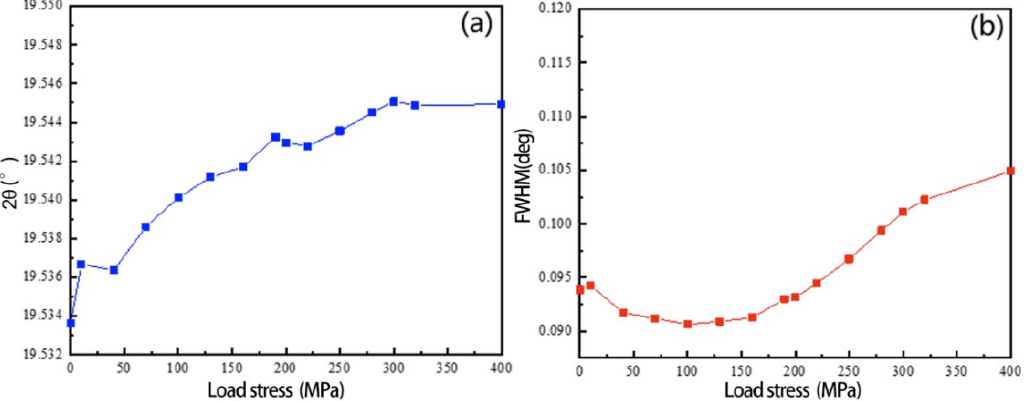
Figure 4. Variation of Al(311) during in situ loading process. ( a ) Diffraction angle; ( b ) FWHM.